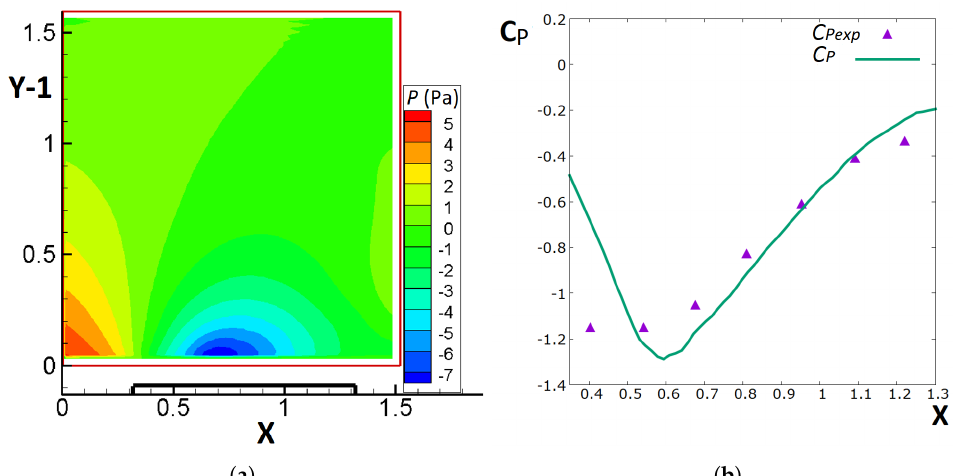
Figure 12. ( a ) Contours of pressure, P (Pa), on plane B (the solid boundary of the cube is denoted by the thick black line, while X and Y are non-dimensional coordinates where a non-dimensional distance of 1 corresponds to 1 cube height). ( b ) Comparison between C P line of the roof of the cube, where the X-axis corresponds to the non-dimensional distance from the upstream boundary of the domain. Flow is from left to right in ( a ) (Adapted with permission from Ref.